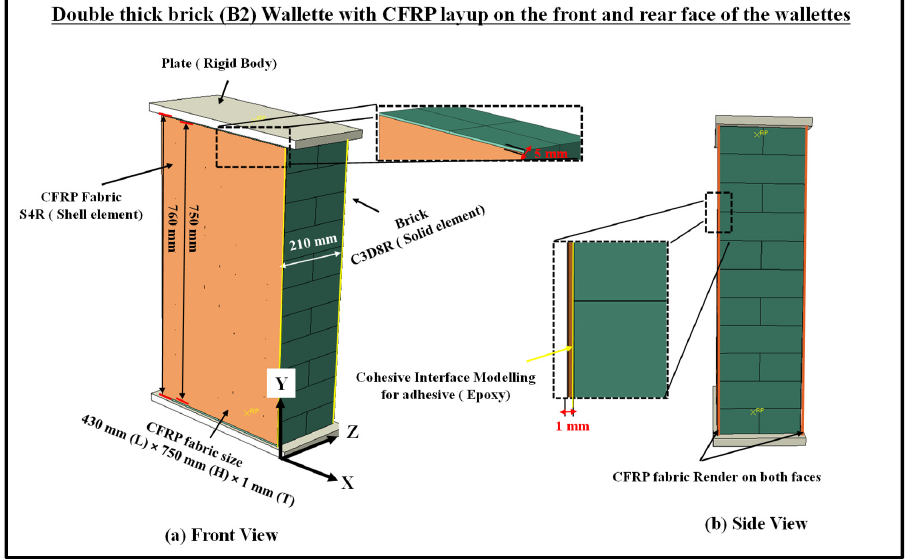
Figure 10. Numerical model of the rendering of CFRP/Auxetic fabric on the faces of masonry wallettes; ( a ) front view and ( b ) side view.